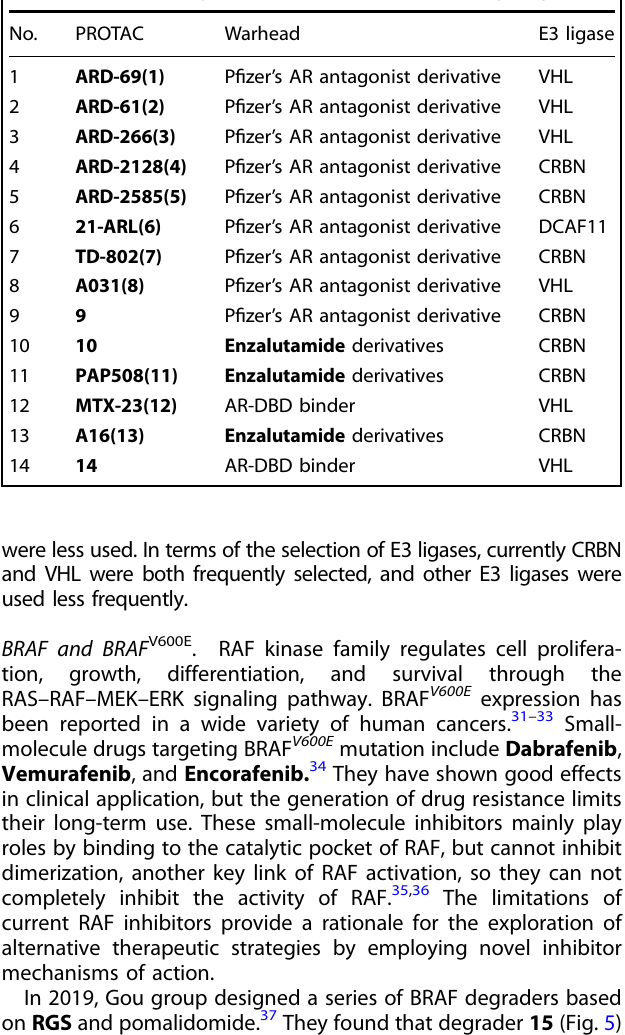
Table 1. The summary and comparison of PROTACs targeting